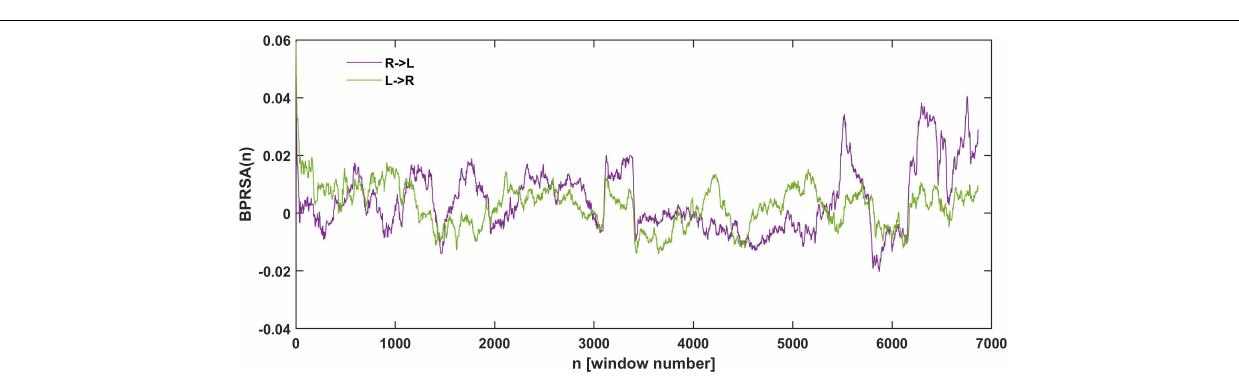
FIGURE 5 | Example of adopted BPRSA results until the fatigue-induced spontaneous task disengagement for one participant with no time lag and window W = 300. The violet time series represents the influence of the right arm in the left arm fluctuations. Green time series represents the influence of the left arm in the right arm fluctuations. An increment in the variations between arms in the last part of the time series, close to the task disengagement, is